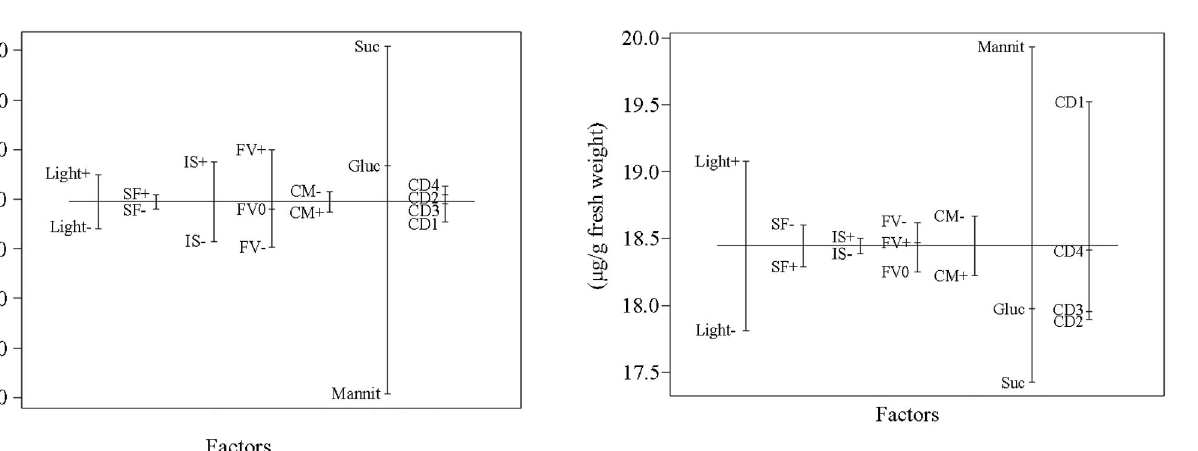
Figure 4. Geraniol content model plot. The abbreviations are the same as in Table